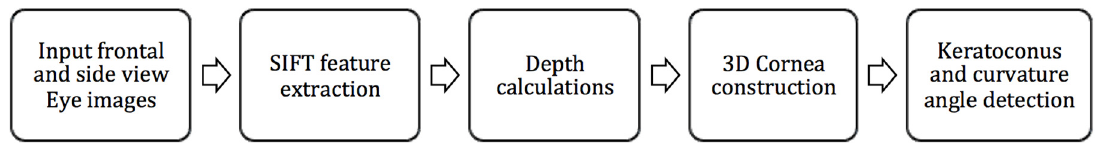
Figure 3. Block diagram of the proposed method.